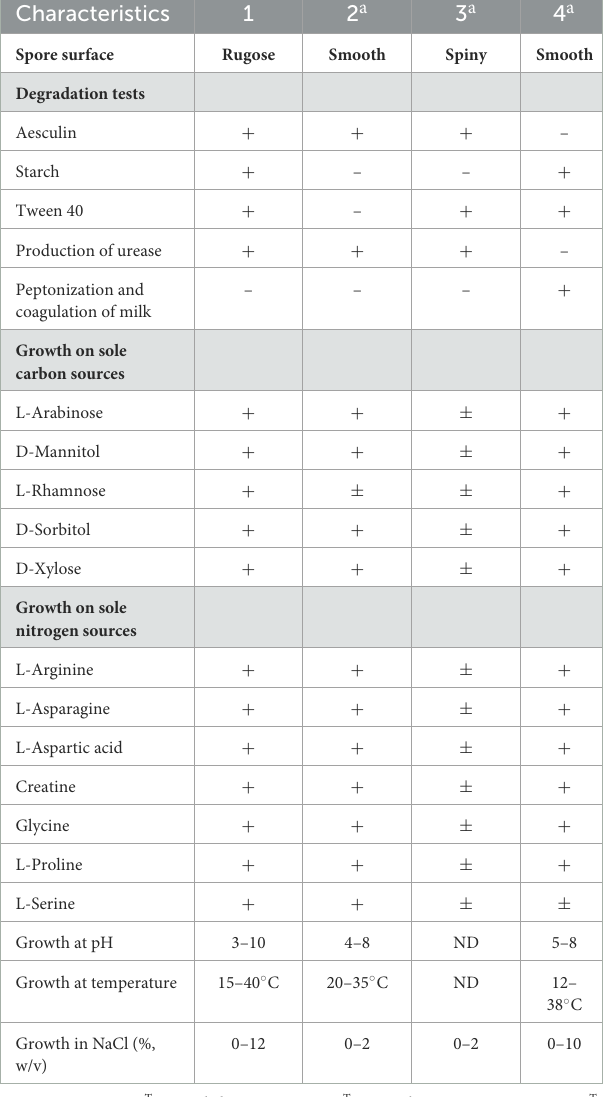
TABLE 2 Average nucleotide identity (ANI) and dDDH values between strain HNM0140 T and its closest Streptomyces species. Type strain